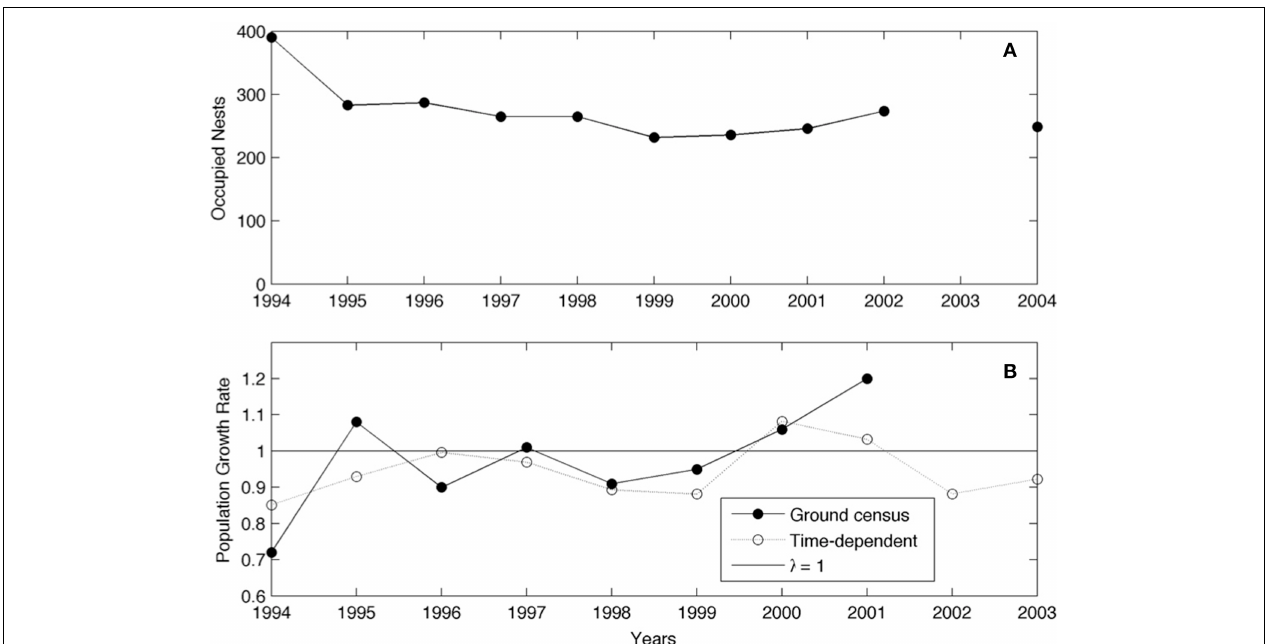
FIGURE 4 | Annual counts of population size (A) and yearly values of the population growth rate, λ , (B) in two subcolonies at Edmonson Point. Values of λ calculated from ground census of the breeding population (solid circles) and by the matrix population model